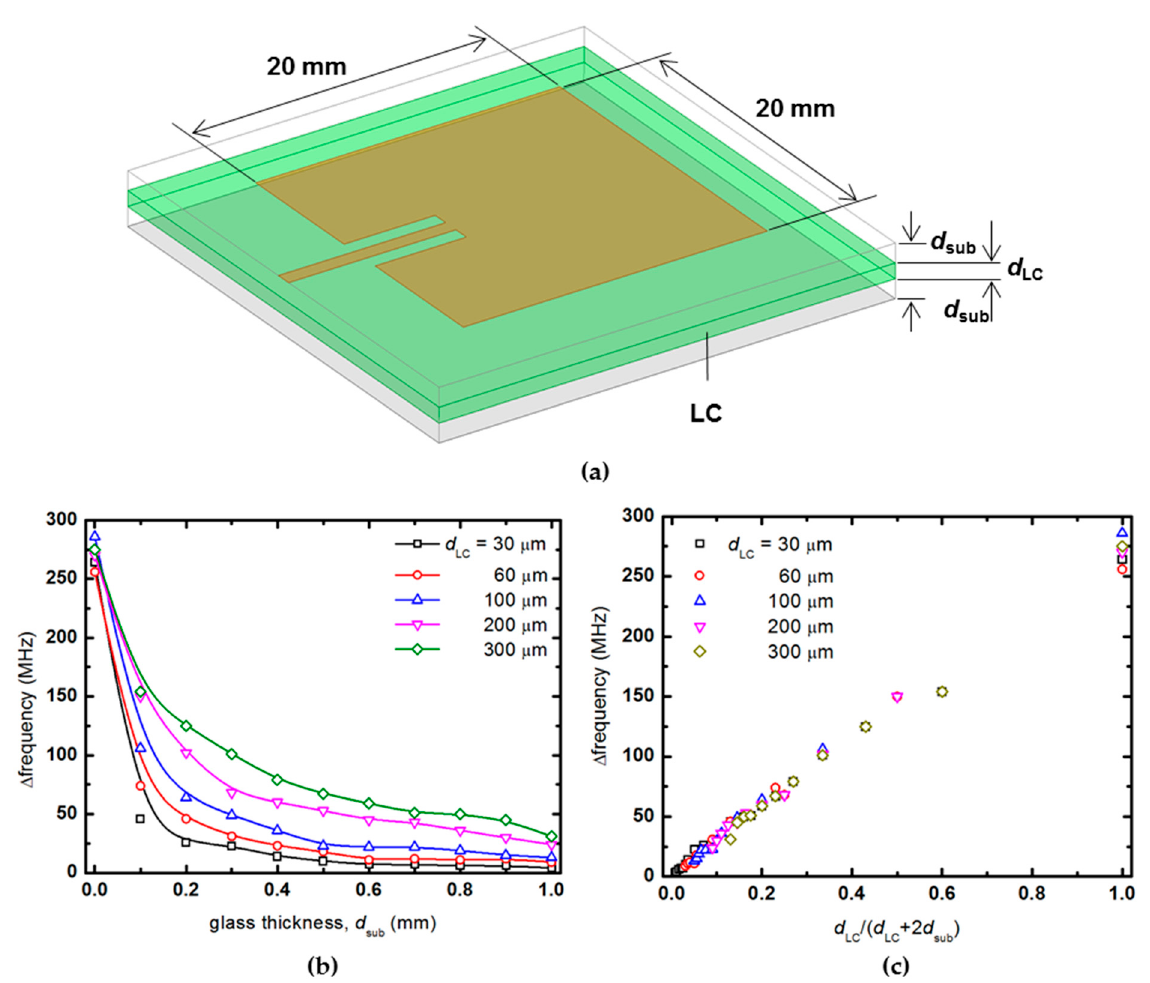
Figure 9. ( a ) Patch antenna substrates to investigate liquid crystal effects and frequency change according to ( b ) the absolute value change in the thickness of liquid crystal and glass and ( c ) the change in the ratio of the liquid crystal cell gap to the total thickness.